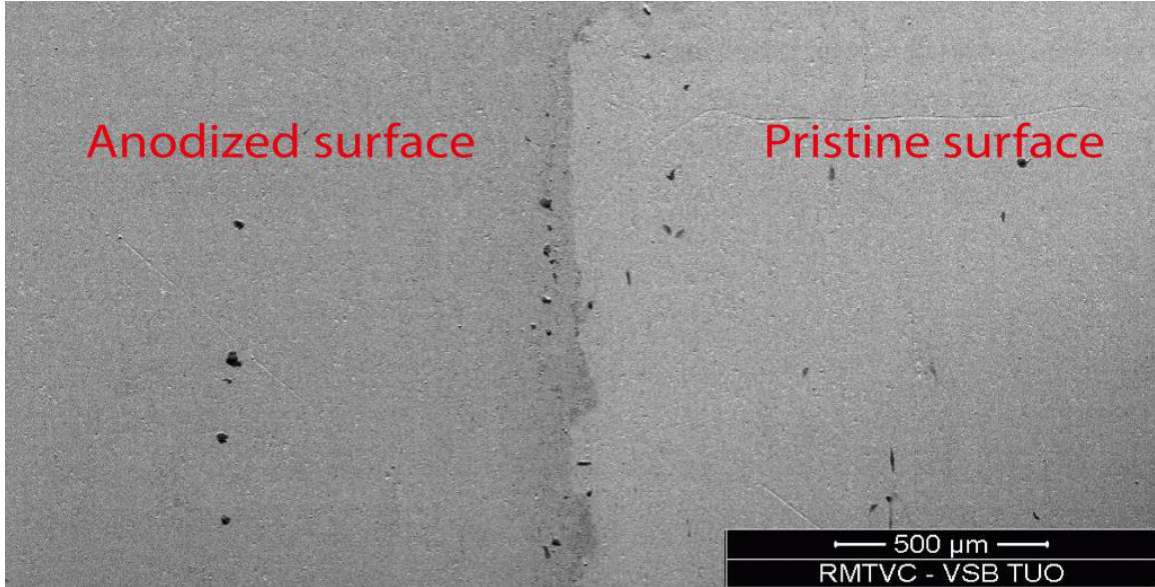
Figure 3. Comparation of an anodically colored and a pristine surface (SEM-BSE) .